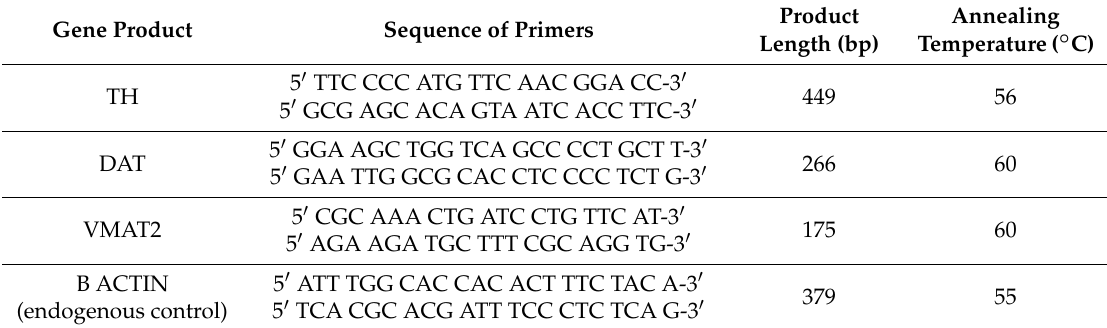
Table 2. Sequence of primers for